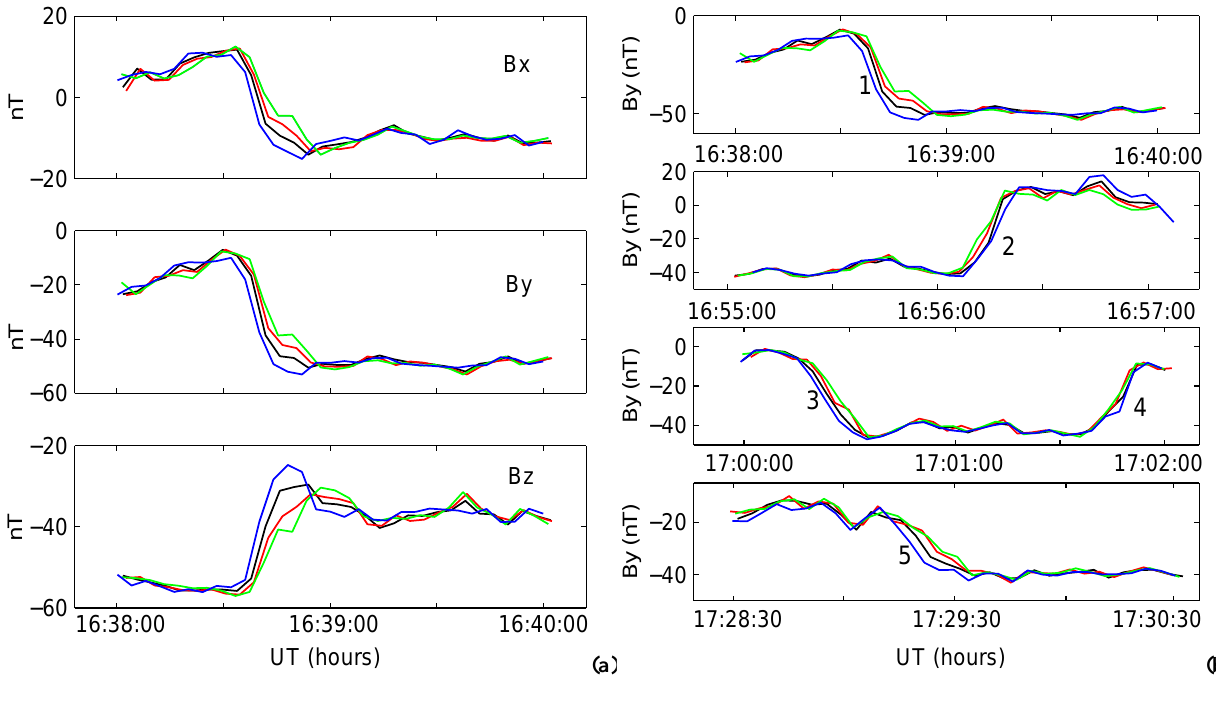
Fig. 9. (a) : Crossing of the inward boundary of the first anti-sunward ion flow event at around 16:38:40 UT in sequence by Cluster SC4 (blue), SC1 (black), SC2 (red) and SC3 (green). Two minutes of the B x , B y and B z data from FGM during 16:38:00–16:40:00 UT are shown. (b) : Crossing of the inward boundaries (1, 3 and 5) of the anti-sunward ion flow events in sequence by SC4 (blue), SC1 (black), SC2 (red) and SC3 (green), and crossing of the outward boundaries (2 and 4) in the reverse sequence by SC3, SC2, SC1 and SC4. Two minutes of B y data from FGM centred around 16:39:00 UT (crossing 1), 16:56:00 UT (crossing 2), 17:01:00 UT (crossings 3 and 4), and 17:29:30 UT (crossing 5) are shown. The outward boundary (6) of the last event is not shown for being comparatively slow.